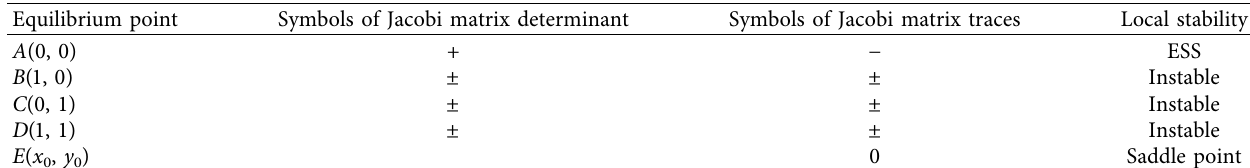
Table 8: Local stability analysis of equilibrium